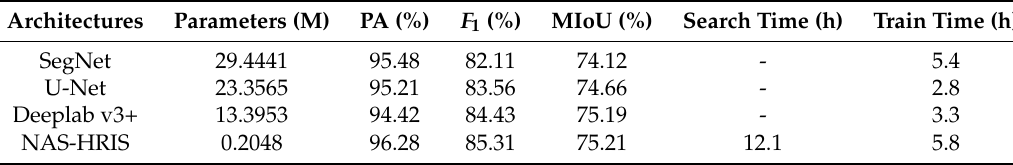
Table 3. Testing result on